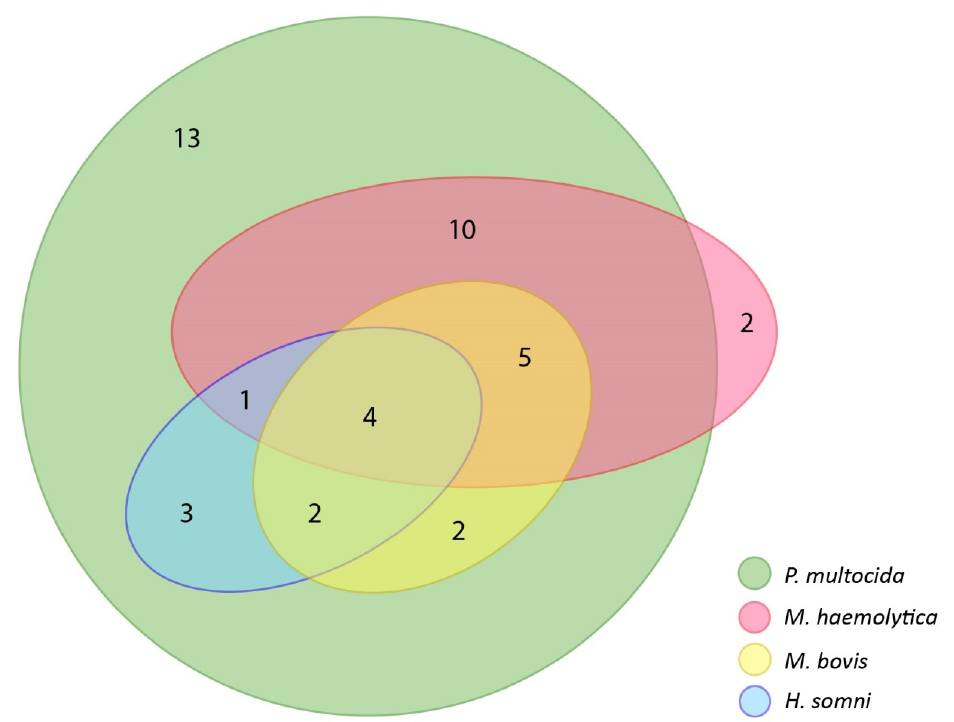
Figure 5. Euler diagram with numbers of occurring bacterial infections and bacterial-only coinfections. Common parts indicate the numbers of coinfections in which a common occurrence of pathogens shown was recorded. H. somni and M. bovis did not occur as a single pathogen infection .